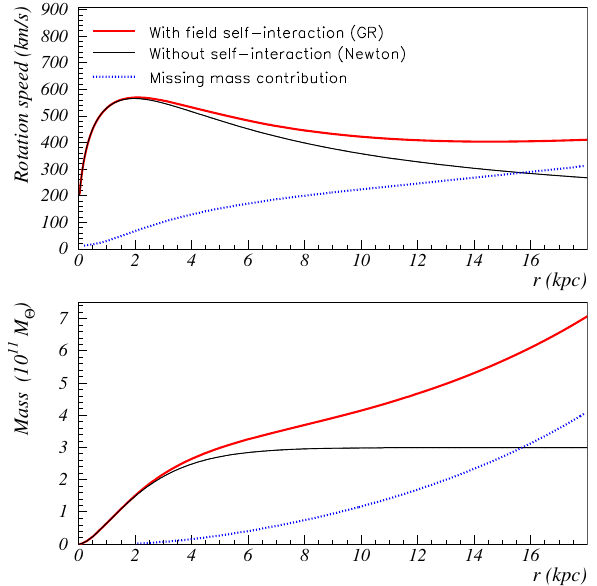
Fig. 5 Top:rotationcurvesgeneratedusingtheresultsinFig.4.Thered line is the rotation curve accounting for General Relativity’s field self- interaction. The black line is without self-interaction (Newtonian case). The dotted line is the quadratic difference of the two. This represents the missing/dark mass that one would need to introduce in an analysis employing Newton’s law, rather than General Relativity, in order to recover the red curve. Bottom: apparent mass contained within r . Each curvecorresponds tooneofthetoppanelrotationcurvesanalyzedusing Newton’slaw.Theredanddottedlinesaretheeffectivemassesobtained from expressing the field self-interaction as an equivalent mass. The black line shows the actual mass